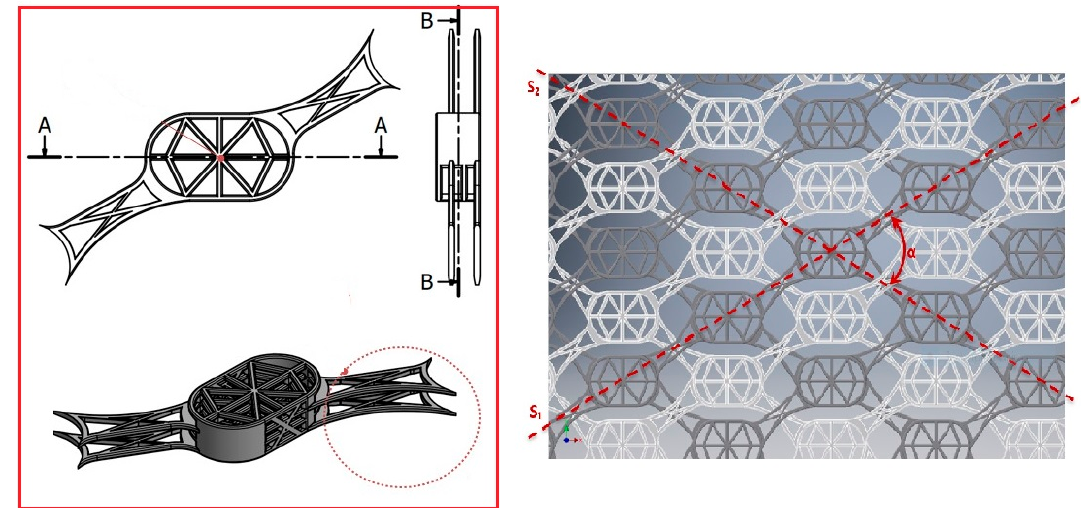
Figure 6. The components of the modular system. Left panel-stratified basal cells, the rigid and flexible connectors. Right panel-the arrangement of modular cells in alternately configuration, so that all rigid connecting bridges align in the S 1 direction, while the flexible ones align in the S 2 direction.